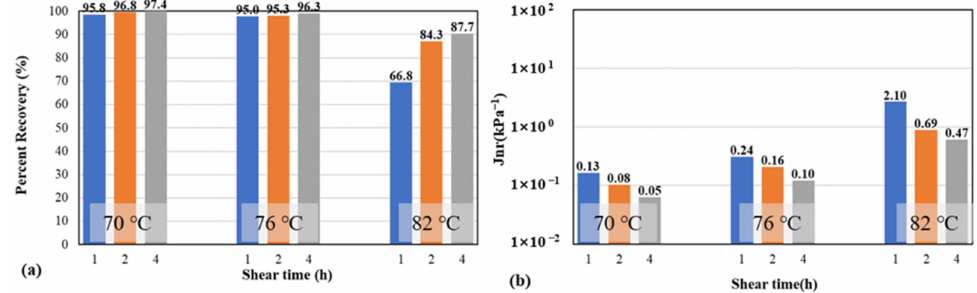
Figure 8. SBS-modified asphalt MSCR test results under different shear times ( a ) R, ( b ) Jnr. At the temperature range of 70 ◦ C to 82 ◦ C, a 1 h shearing time shows the weakest elastic network, hence its MSCR results are also the worst (low R with high Jnr). SBS- modified asphalt that was sheared for 2 h and 4 h had better results, with 4 h shearing time exhibiting the best